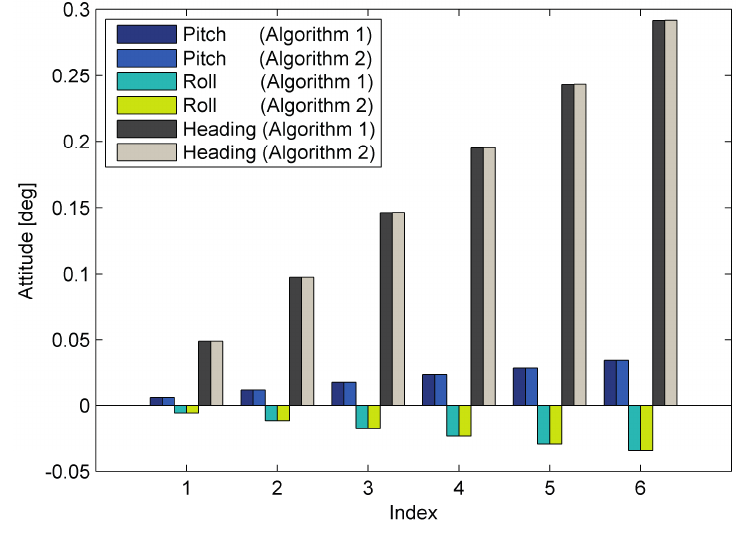
Figure 3. Alignment results of the six